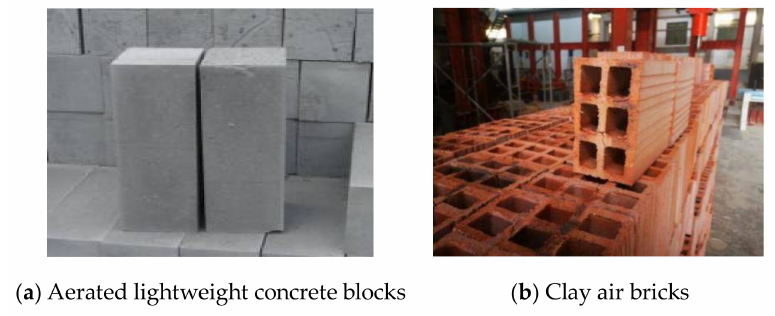
Figure 3. Blocks of infill